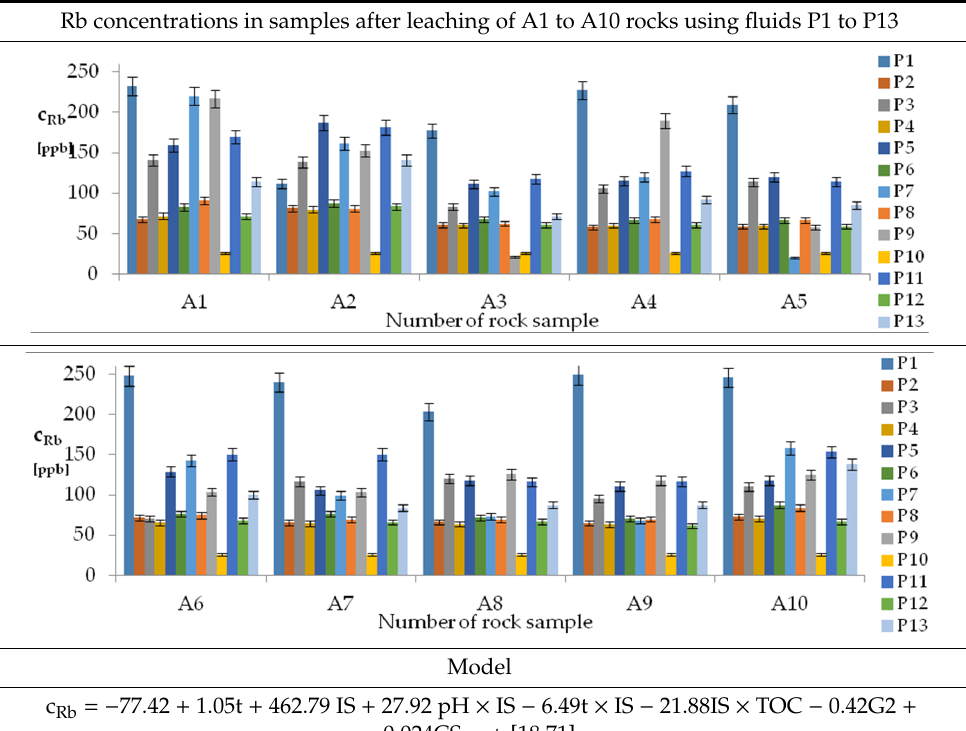
Table 9. Results of leaching samples A1 to A10 rocks using fluids P1 to P13 for Rubidium (Rb). Rb concentrations in samples after leaching of A1 to A10 rocks using fluids P1 to P13